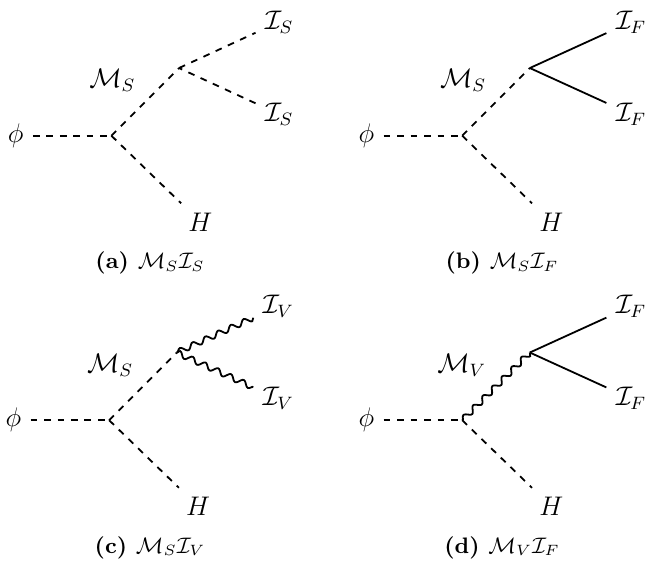
Figure 12. Mono-Higgs ( H ) + E miss